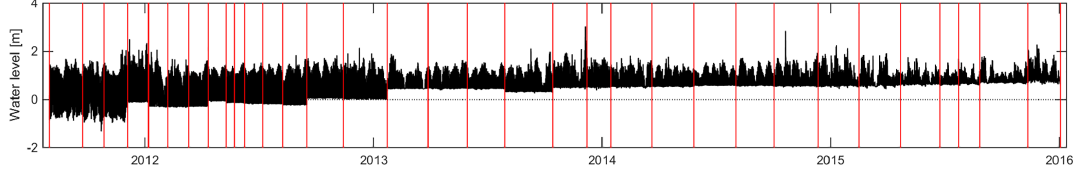
Figure 4. Simulated water level (in m NAP) inside the lagoon from 3 August 2011 to 4 January 2016, where the vertical red lines signify topographic